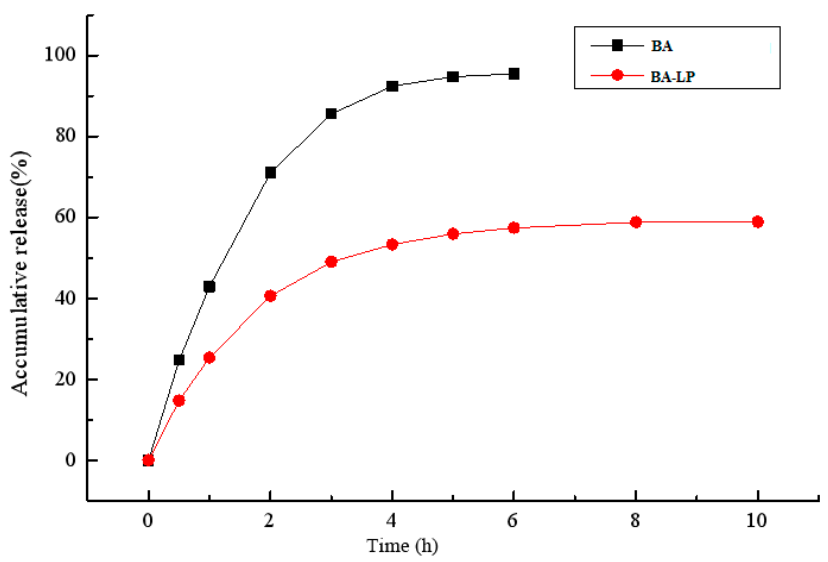
Figure 2. The in vitro release profile of BA solution and BA-LP.